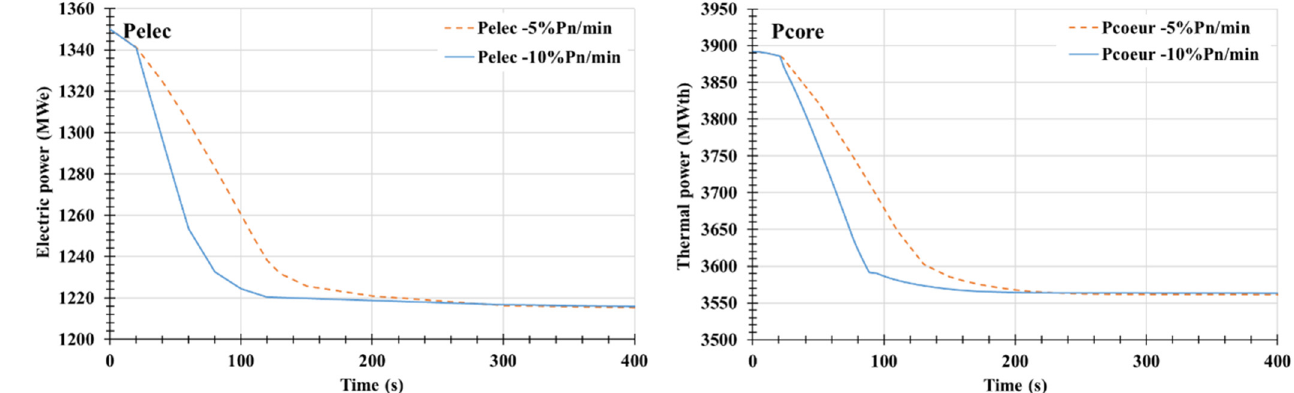
Fig. 11. Electrical and thermal power for a constrained transient at –